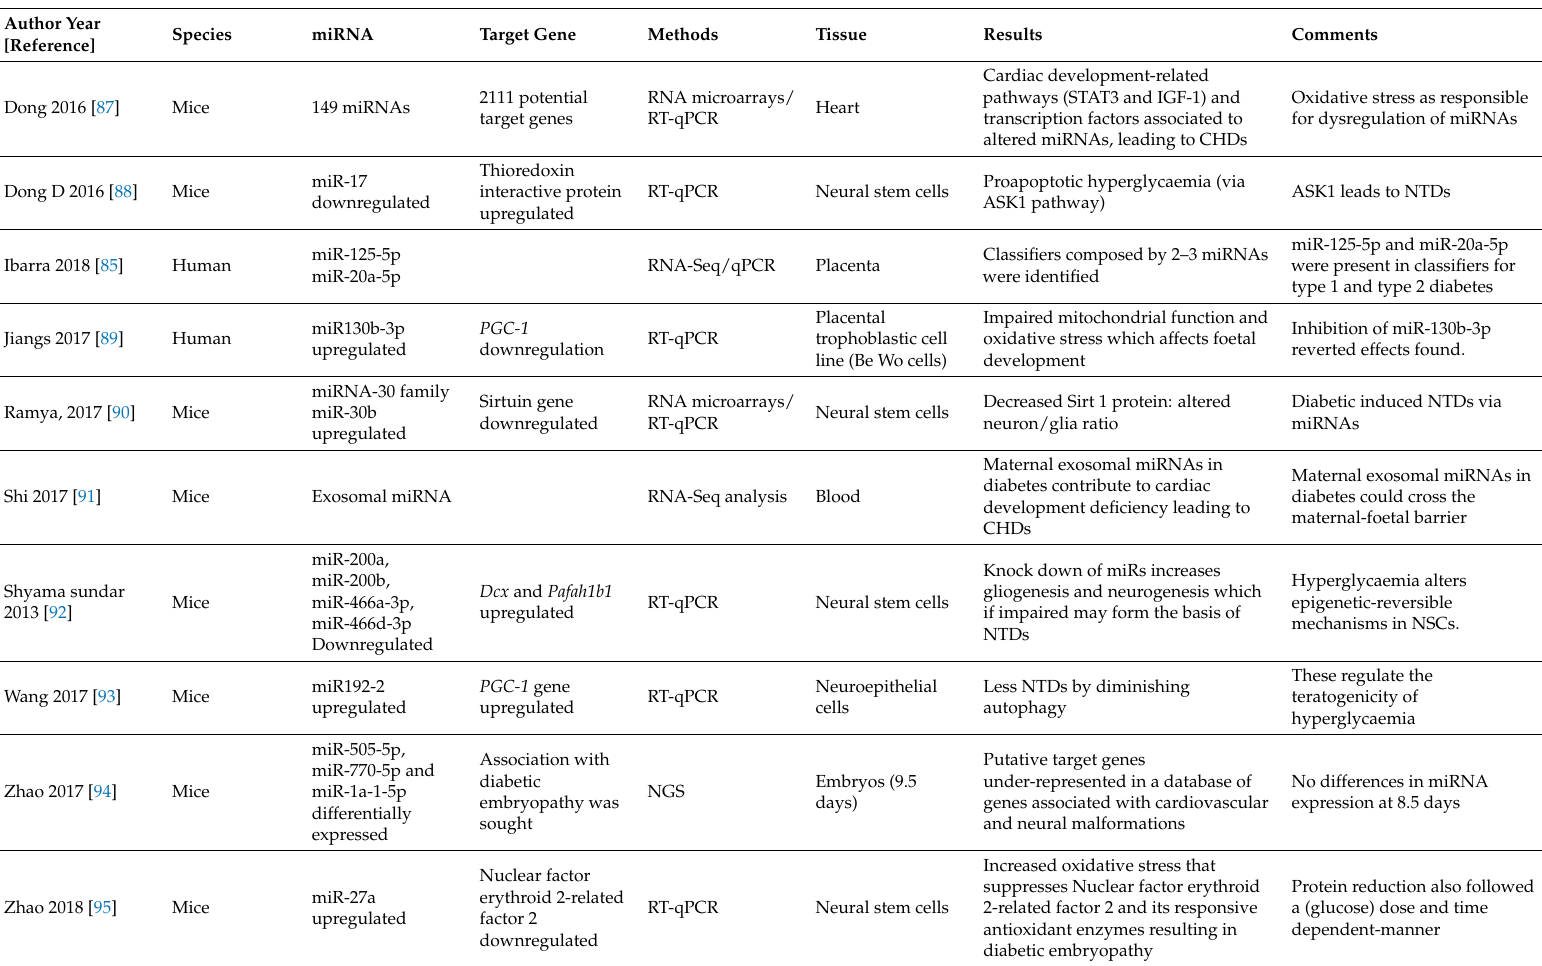
Table 3. Studies assessing the effect of pre-gestational diabetes on placental and offspring